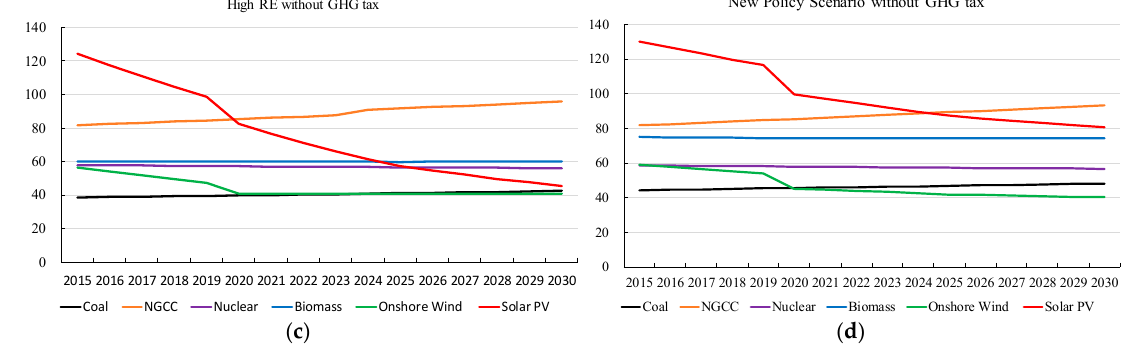
Figure 2. LCOE ($/MWh) of different electricity technologies in the “high renewable energy penetration scenario” (ERI& NDRC) and “New Policies” (IEA) scenario. ( a ) High RE with GHG tax; ( b ) New Policy scenario with GHG tax; ( c ) High RE without GHG tax; and ( d ) New Policy scenario without GHG tax.